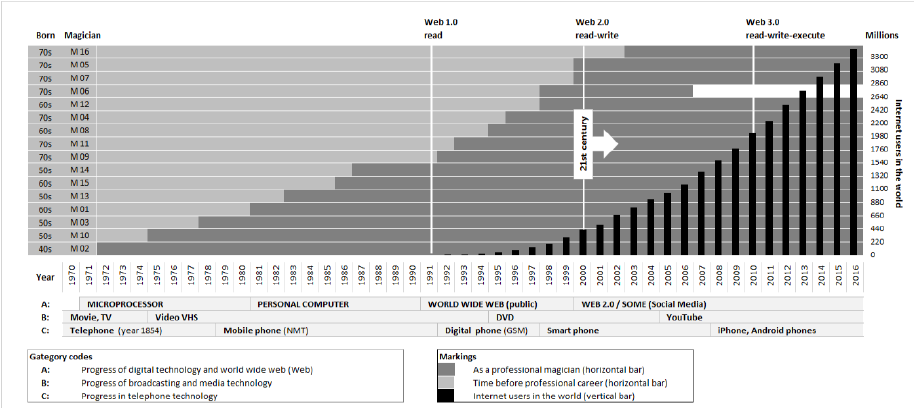
Figure 2. Relations between professional careers of the interviewed magicians and technological advances from 1970 to 2016 (ICT Lounge, 2016; Internet Live Stats, 2016; Rissanen et al.,